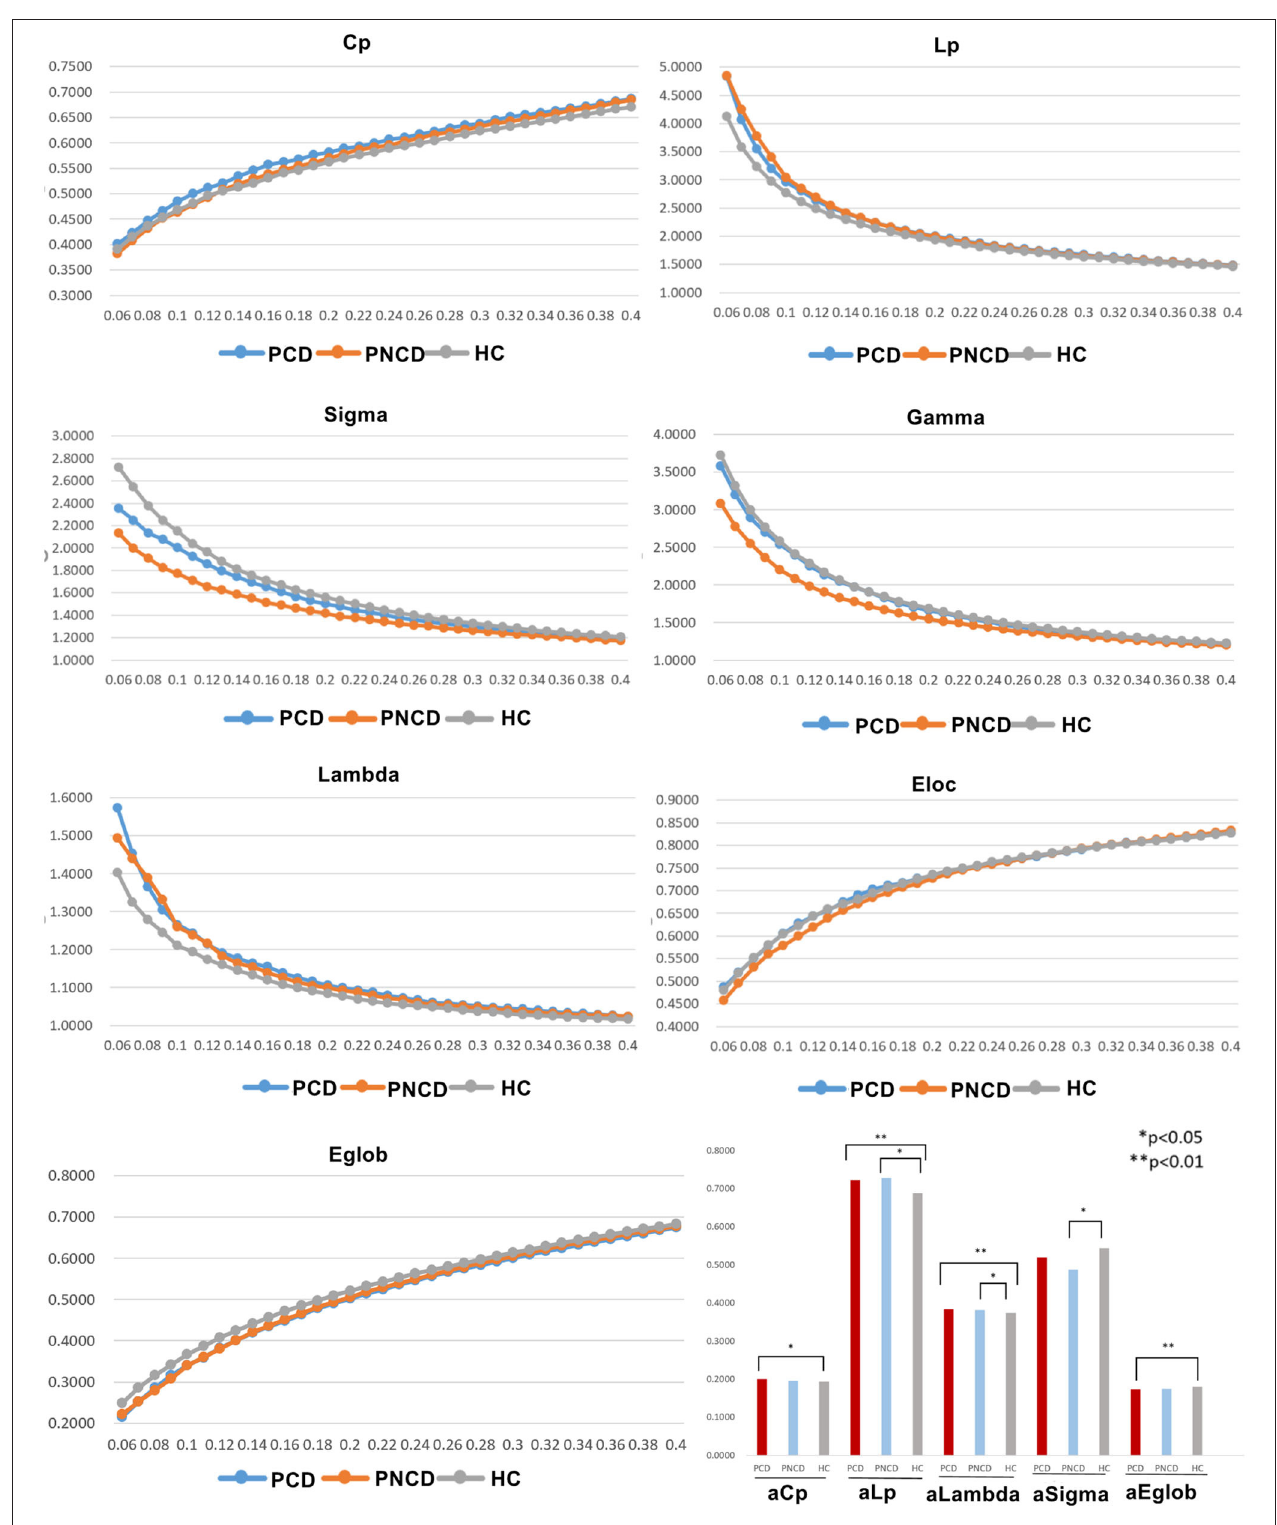
FIGURE 1 | The differences in global metrics of the brain functional networks among presbycusis patients with cognitive decline, presbycusis patients without cognitive decline, and healthy controls. PCD, presbycusis patients with cognitive decline; PNCD, presbycusis patients without cognitive decline; HC, healthy controls; Cp, clustering coefficient; Lp, shortest path length; sigma ( δ ), small-world characteristic; gamma ( γ ), normalized clustering coefficient; lambda ( λ ), normalized characteristic path length; Eloc, local efficiency; Eglob, global efficiency; aCp, AUC in Cp; aLp, AUC in Lp; aLambda, AUC in Lambda; aEglob, AUC in Eglob. * p < 0.05, ** p <